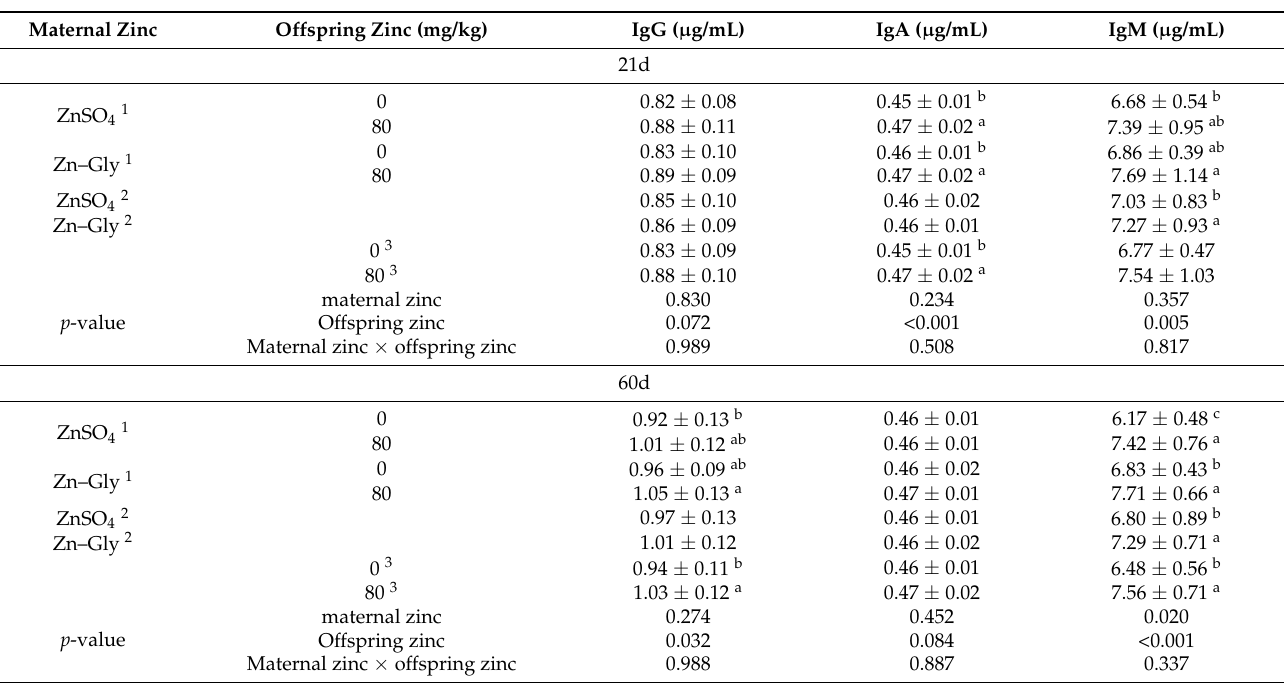
Table 9. Effects of maternal Zn in conjunction with their offspring dietary Zn supplementation on immune indexes in serum of offspring broilers (mean ±